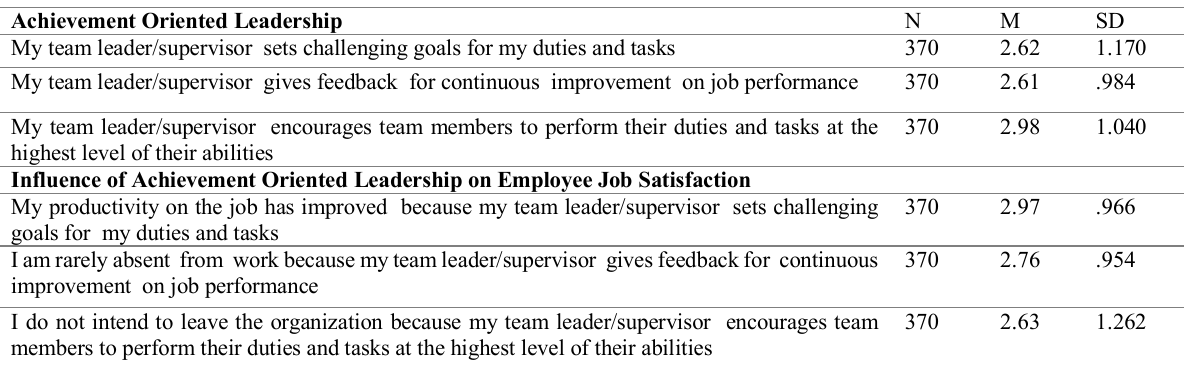
Table 6: Mean and standard deviation for achievement-oriented leadership